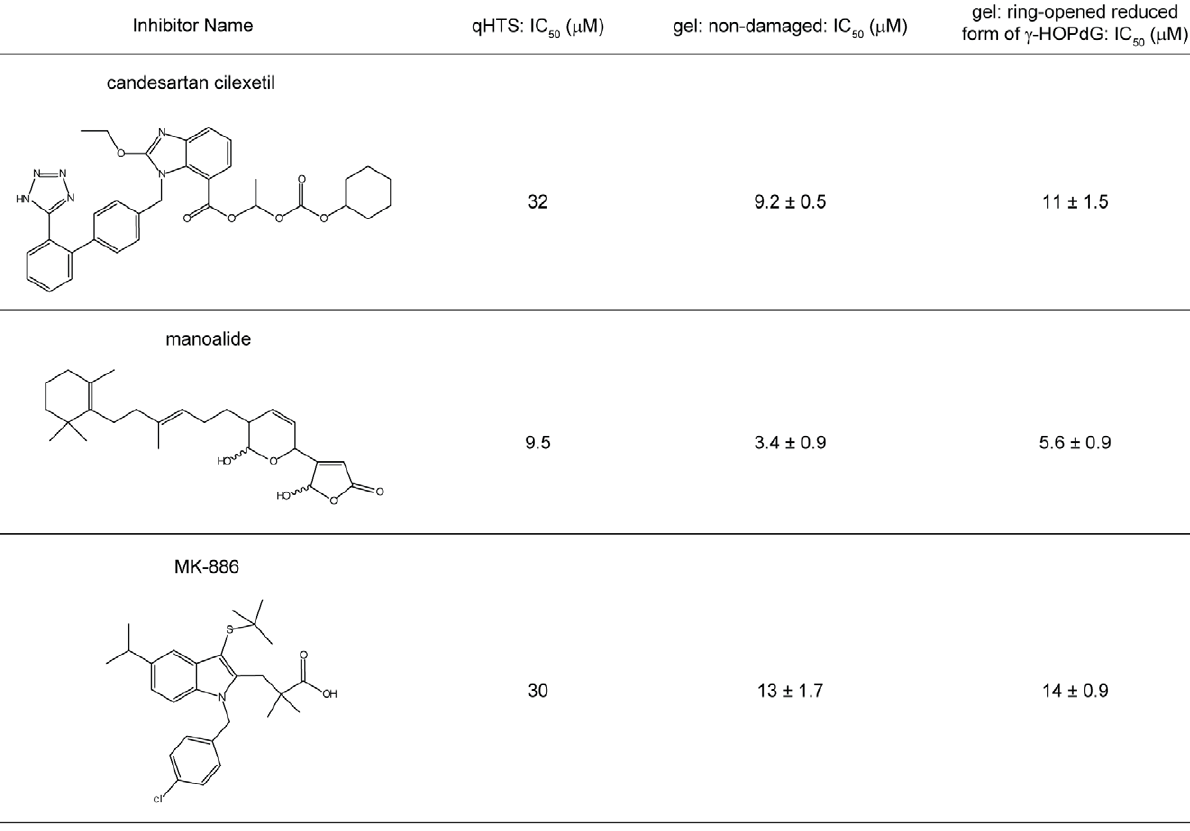
PLOS ONE | www.plosone.org